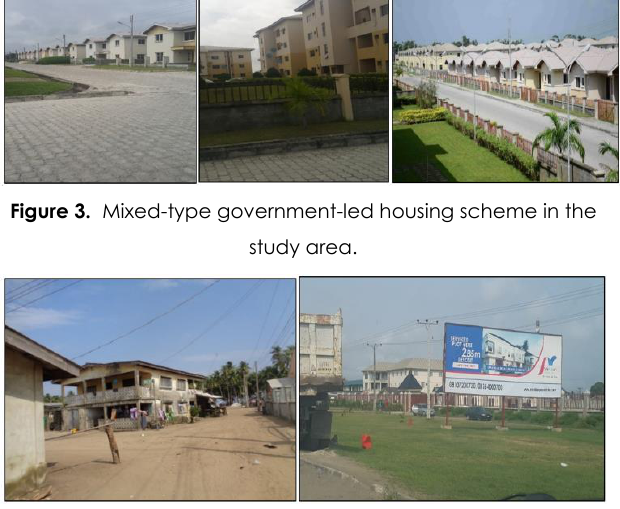
Figure 4. Self-help housing development and Private developer-led housing.